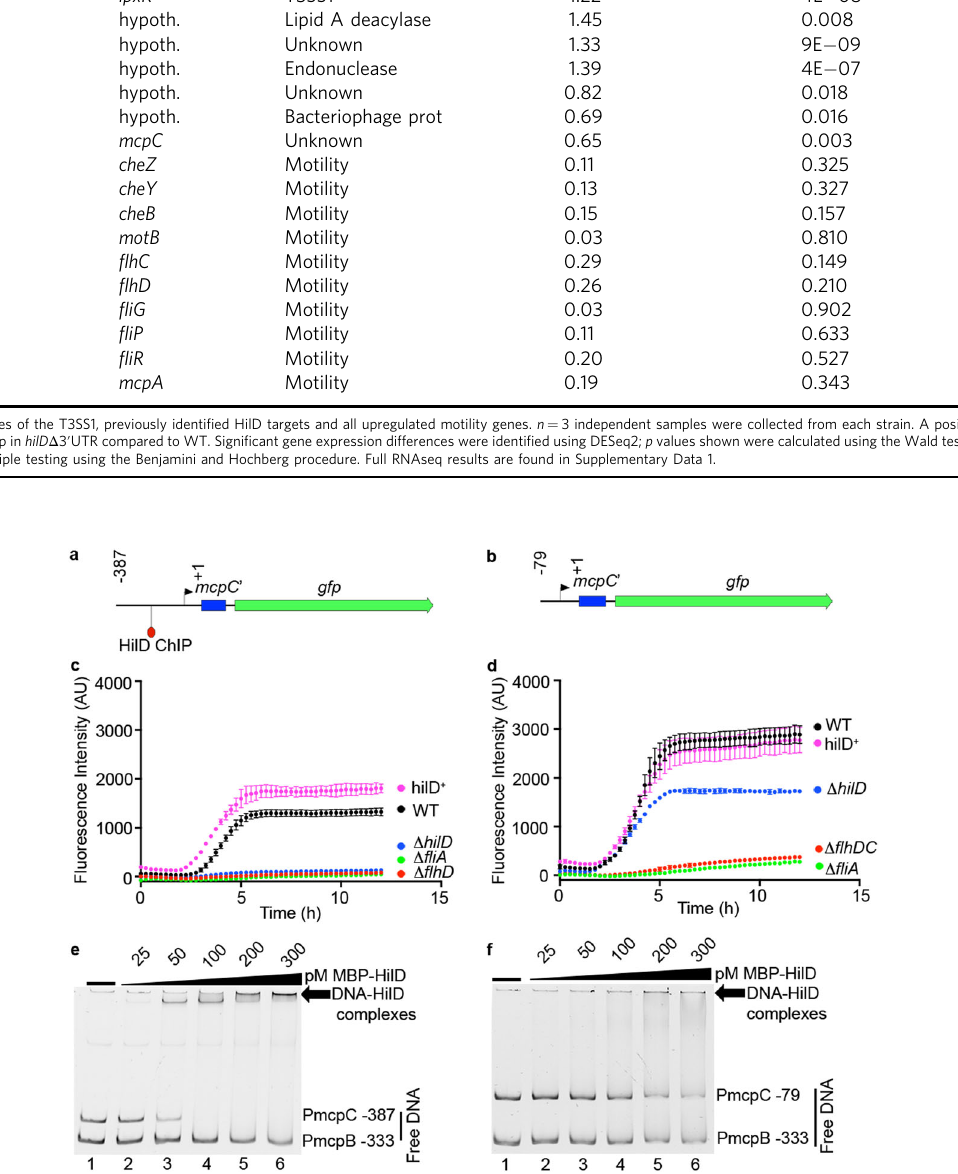
Fig. 2 mc pC is regulated by a Class III fl agellar promoter and dependent on HilD. a , b Schematic of P mcpC - gfp transcriptional reporters: a P mcpC − 387 gfp and b P mcpC − 79 gfp . Numbers indicate the nucleotide locations with reference to the start ATG ( + 1). mcpC ’ represents the fi rst 93 nucleotides of coding sequence of mcpC . The arrow indicates the predicted Class III promoter. HilD ChIP indicates the peak position of HilD binding identi fi ed by ref. 28